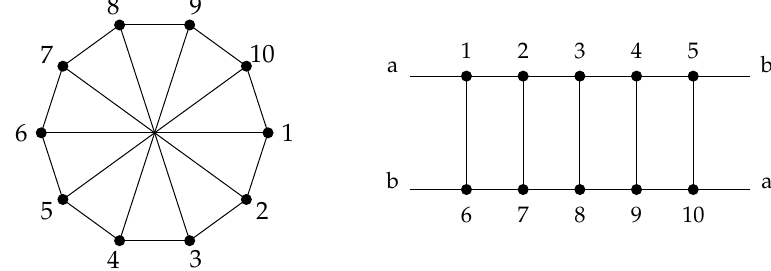
Figure 1. Two pictures of V 10 . In general, V 2 n is obtained from a 2 n -cycle by adding the n main